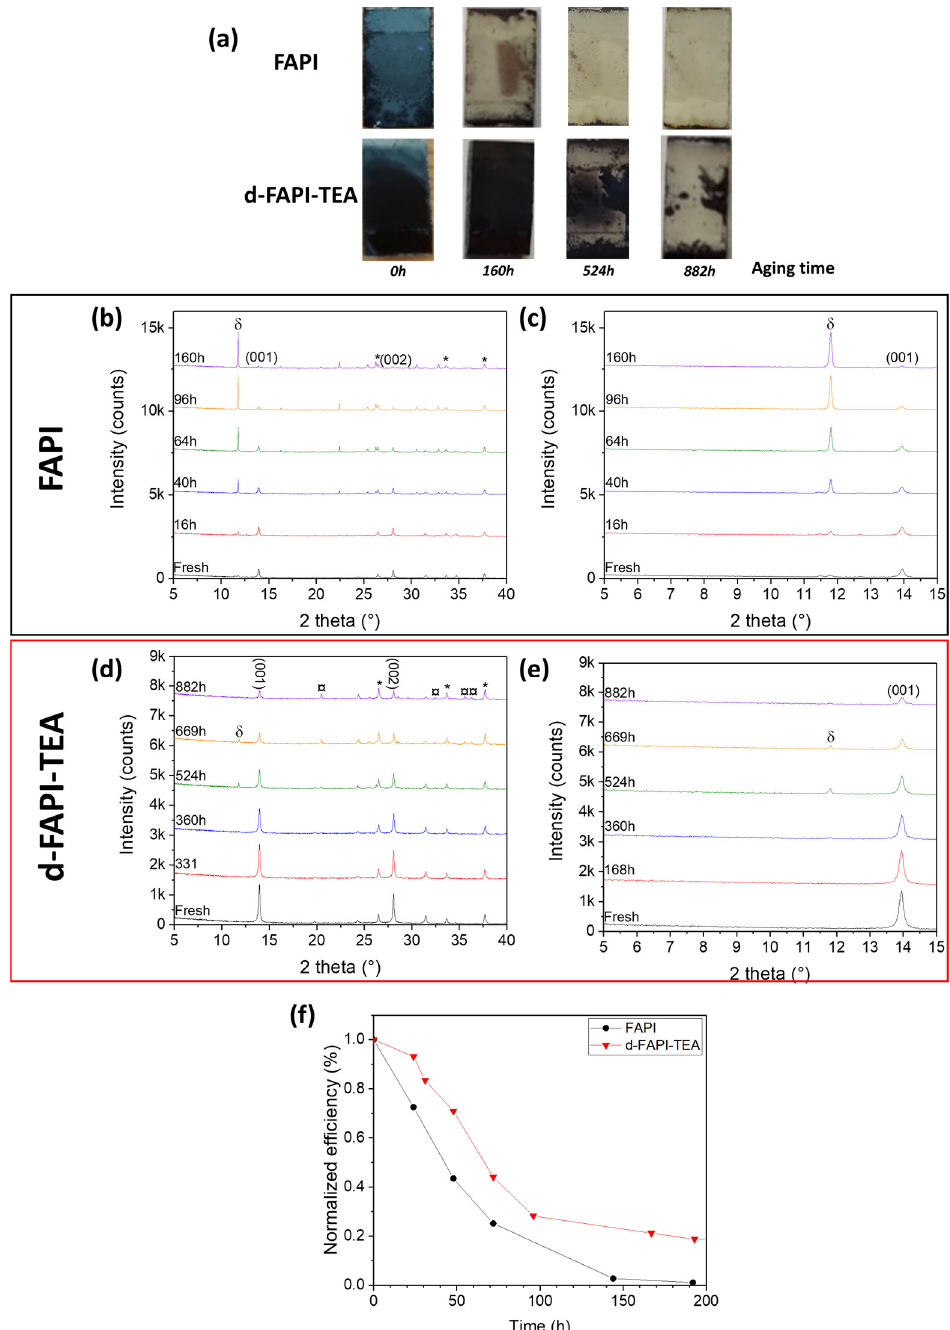
Figure 7. ( a ) Evolution of FAPI and d-FAPI-TEA films aspect upon aging (50–70% RH, T ◦ =15–20 ◦ C, ambient light). ( b ) Complete XRD patterns recorded upon the stability test of FAPI films. ( c ) Same as ( b ) zoomed between 5–15°. FTO peaks are indicated by the * symbol. δ indicates yellow hexagonal δ -FAPI phase. ( d ) Complete XRD patterns recorded upon the stability test of d-FAPI-TEA films. ( e ) Same ( d ) zoomed between 5–15 ◦ . FTO peaks are indicated by the * symbol. δ indicates yellow hexagonal δ -FAPI phase. ¤ symbol indicates Pb(OH)I phase. ( f ) Evolution of normalized PCE unencapsulated FAPI and d-FAPI-TEA devices. Storage was made in air under ambient conditions (50–70% RH; T ◦ = 15–20 ◦ C) and ambient light.